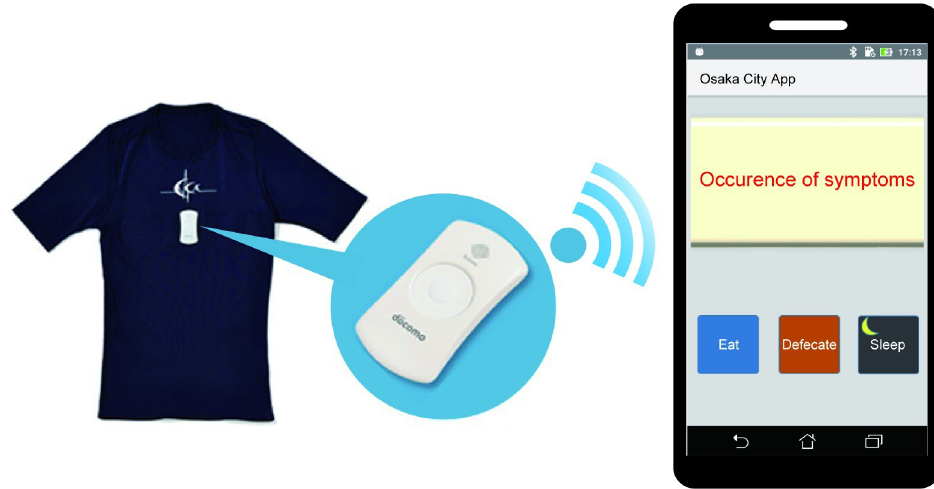
Fig 1. T-shirt-type wearable device and smartphone application software. Heart rate variability (HRV) was measured using a T-shirt wearable device attached to a transmitter in front of the T-shirt. The HRV data were transferred and recorded on a smartphone using Bluetooth. At the same time, life events, such as abdominal symptoms, defecation, eating, and awakening or sleep, were recorded in real time using a smartphone application software during HRV